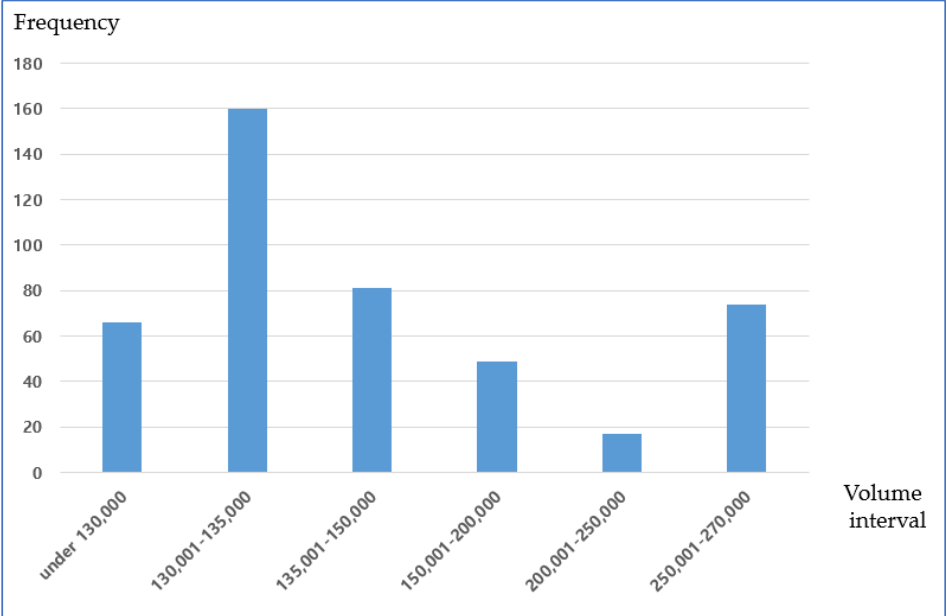
Figure 3. Distribution of LNG volume of calling ships.